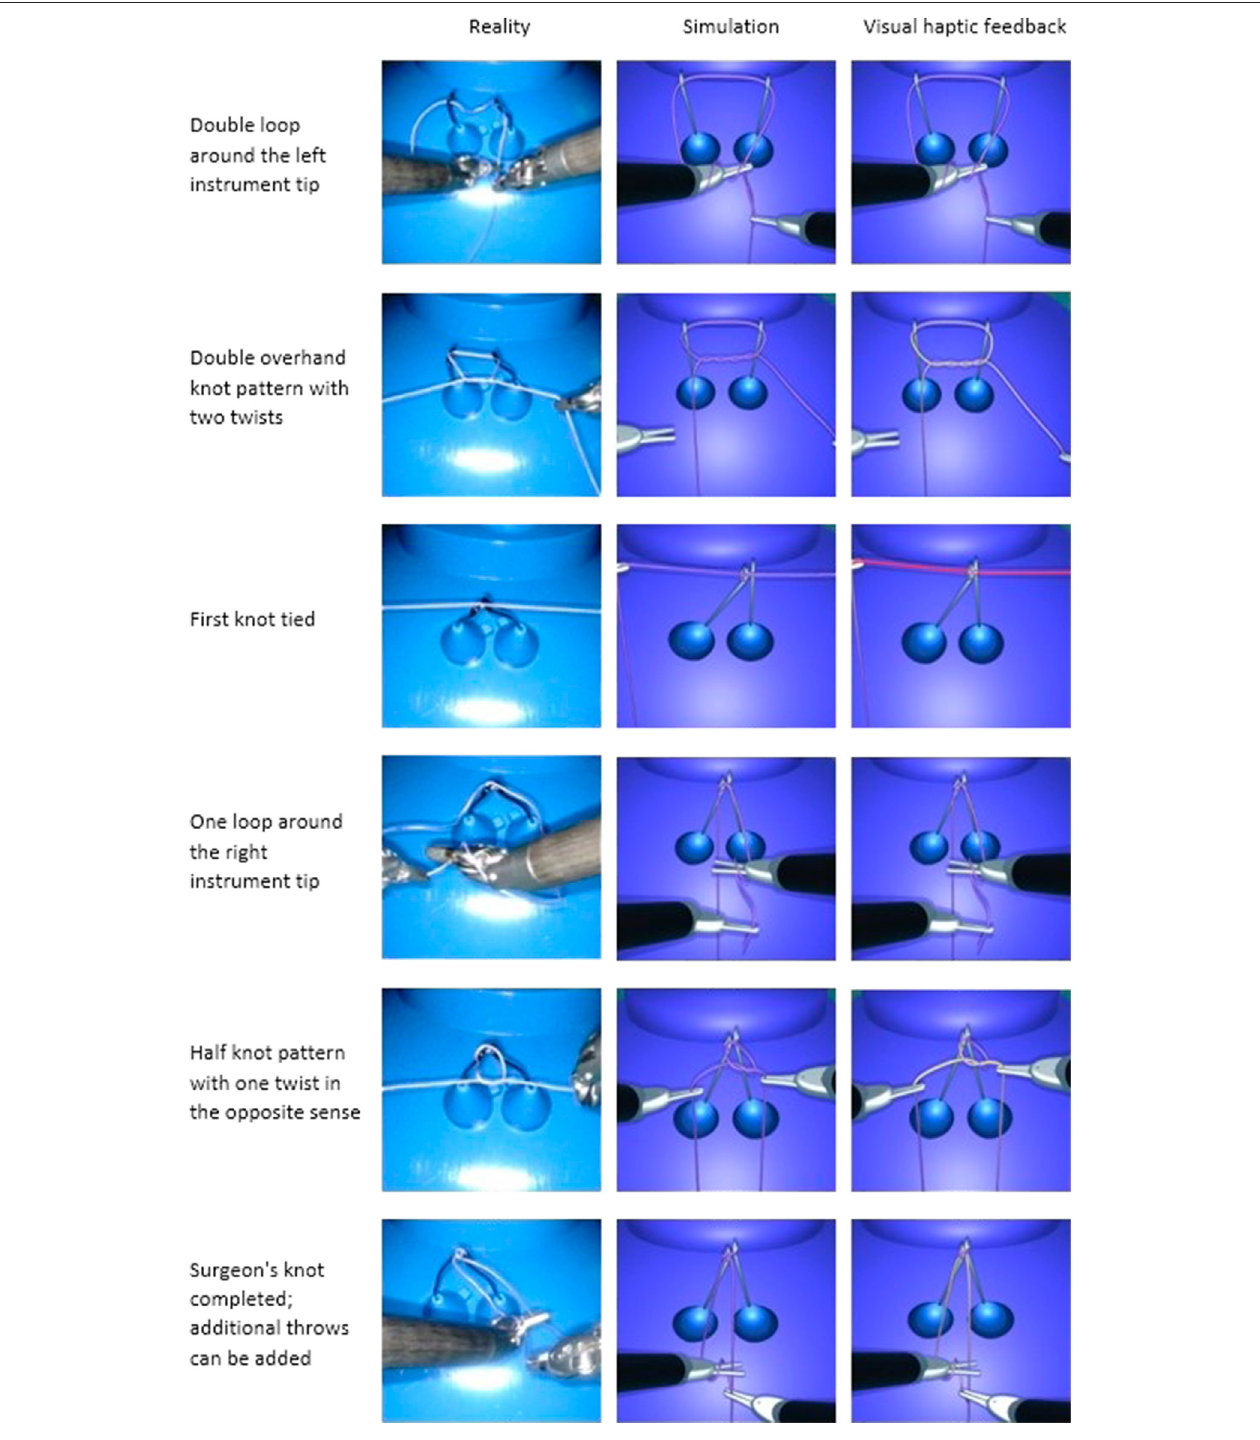
FIGURE 15 | Task performance comparison between a real robotic system and the simulation. The knot-tying sequence is based on a surgeon ’ s knot. The task with the da Vinci Xi system is shown on the left, and the simulated task is shown without (middle) and with visual haptic cues (right).